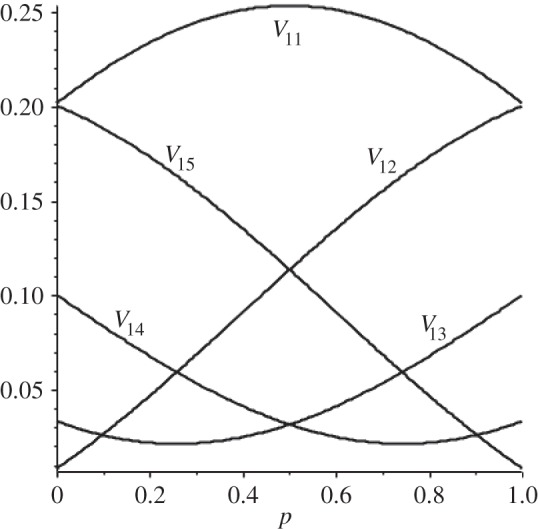
Entries in eW=Circ(V11,V12,V13,V14,V15).